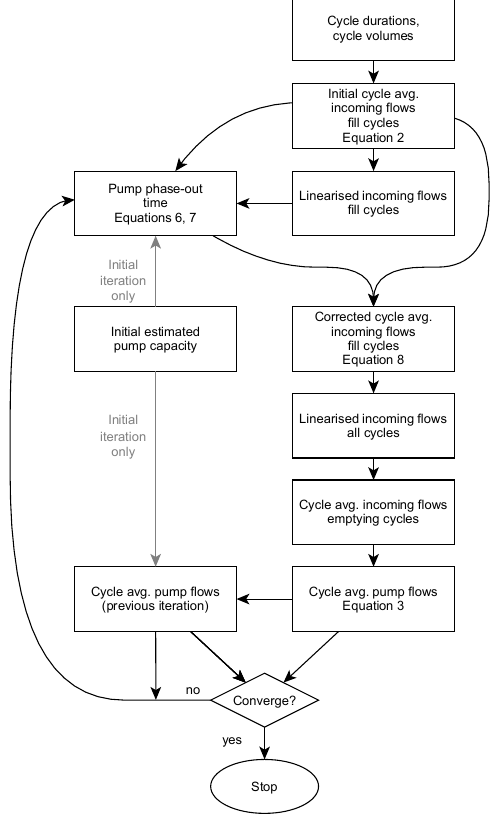
Figure 3. Detailed flowchart of the iterative flow calculation algorithm.